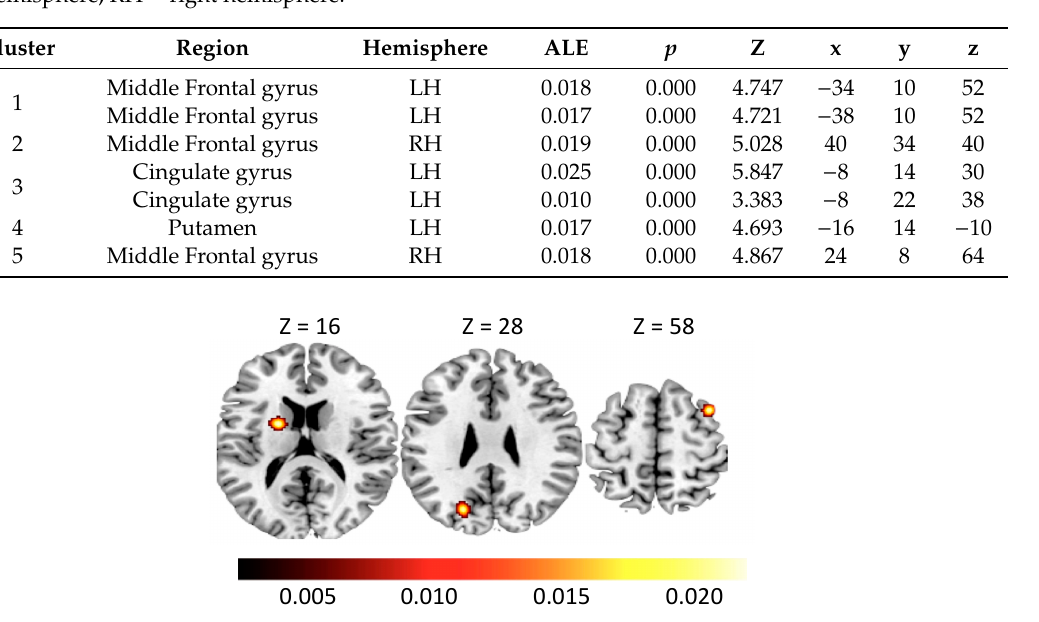
Figure 3. Clusters of activation in Alcohol Use Disorder subjects. MNI coordinates are provided. The color bar indicates ALE